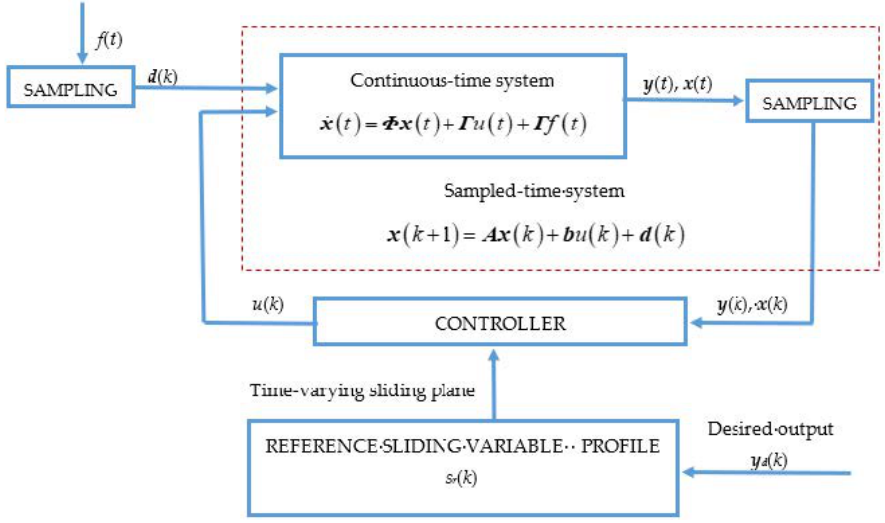
Figure 1. Structure of the closed-loop system.